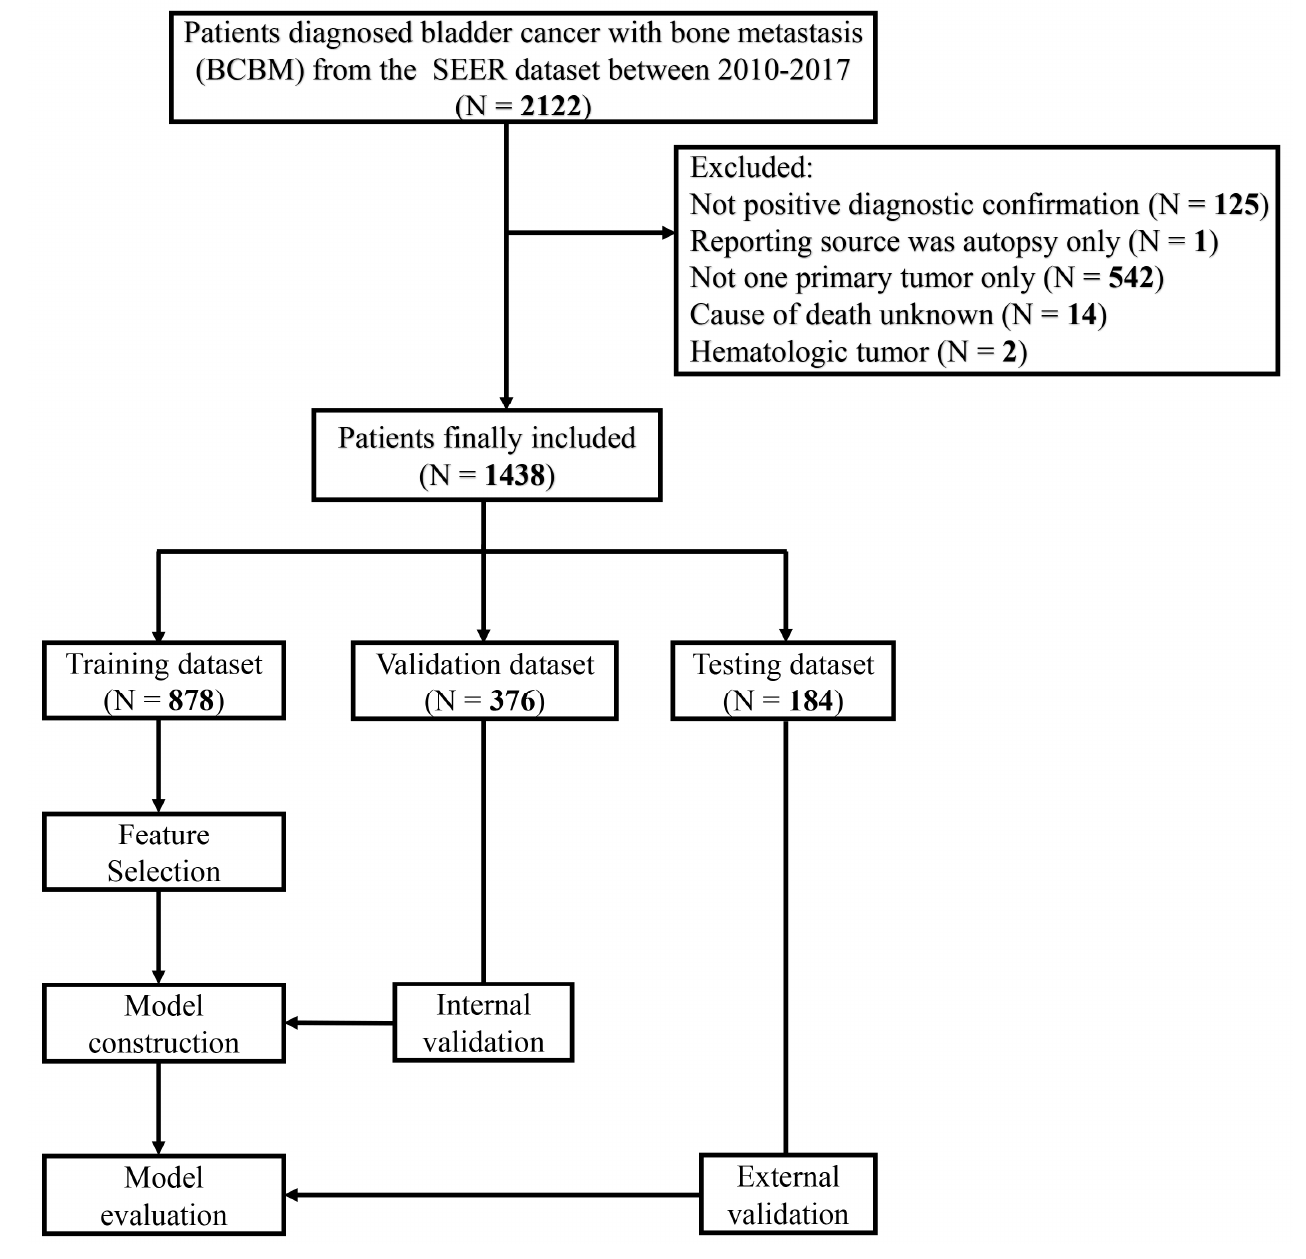
Figure 1. Workflow of the patient selection and model development.